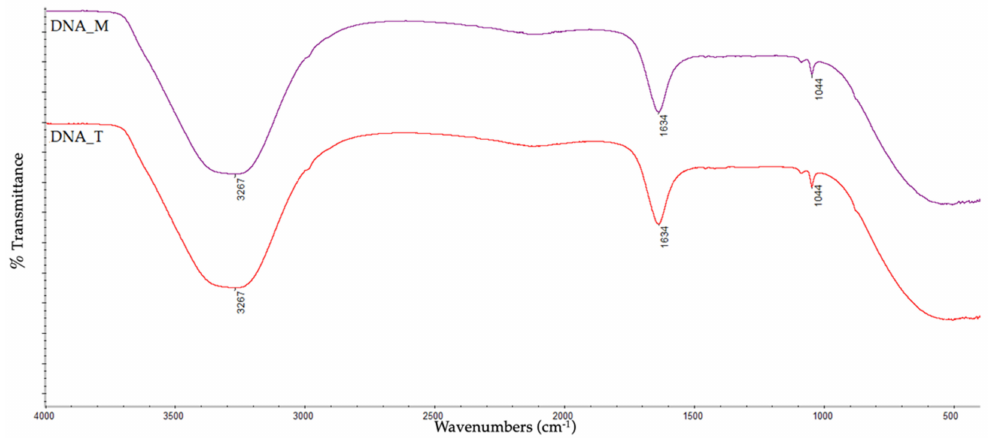
Figure 4. ATR–IR spectra for isolated DNA from experimental